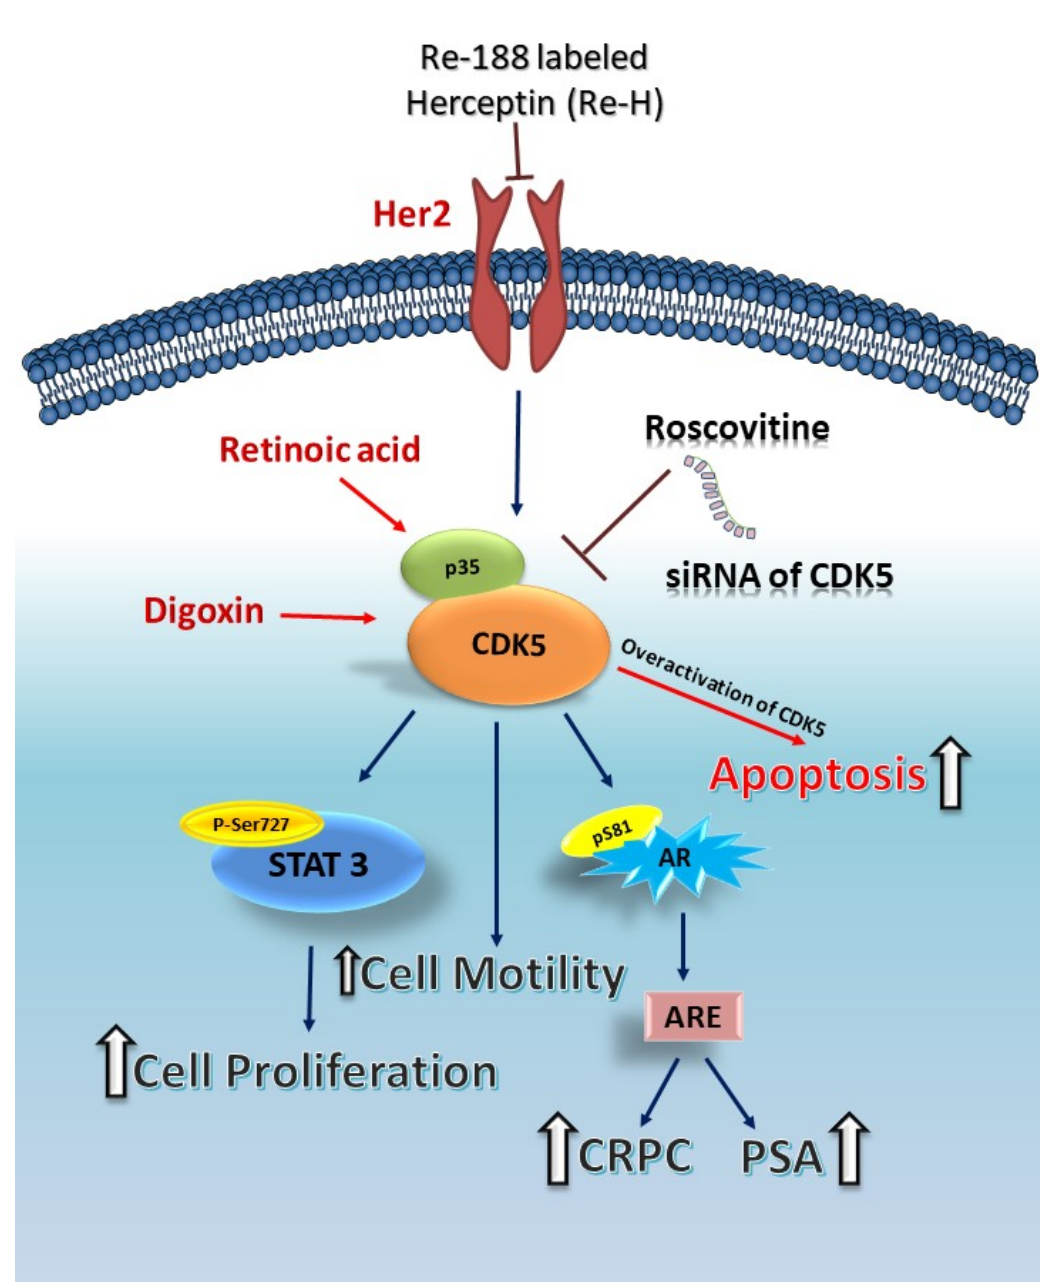
Figure 3. A schematic summary of the regulatory role of CDK5 in prostate cancer. Re-188 labeled Herceptin (Re-H) targets the Her2 receptor and reduces the expression level of p35. CDK5 activates signal transducer and activator of transcription 3 (STAT3) and AR proteins at the specific phosphorylation site. Activation of STAT3 or AR causes prostate cancer proliferation and castration resistance of prostate cancer. Blocking of CDK5 by Roscovitine or small interfering RNA (siRNA) decreases the cell proliferation ability and prostate-specific antigen (PSA) level. CDK5 also plays a regulatory role in apoptosis of prostate cancer cells. Digoxin and Retinoic acid trigger p35 or p25 activation and cause overactivation of CDK5, resulting in apoptosis.